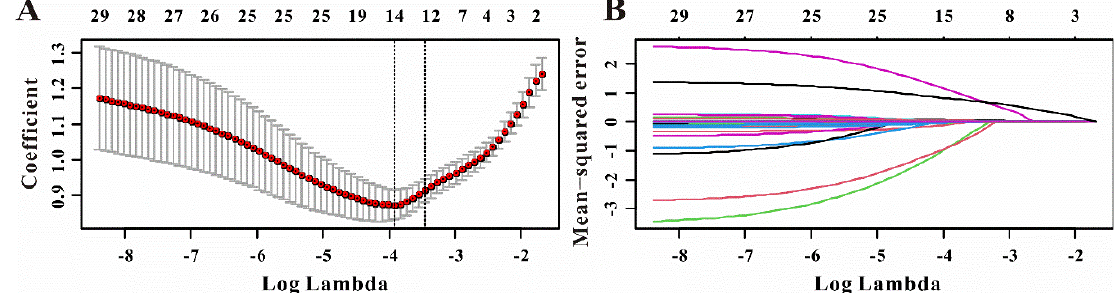
Figure 5. Selection of significant factors associated with CVS−AKI by LASSO logistic regression model. ( A ) Identification of tuning parameter (λ) in the LASSO model. ( B ) Profiles of LASSO coefficient for clinical features. Table 3. Logistic regression analysis for the predictors of CVS − AKI selected by LASSO